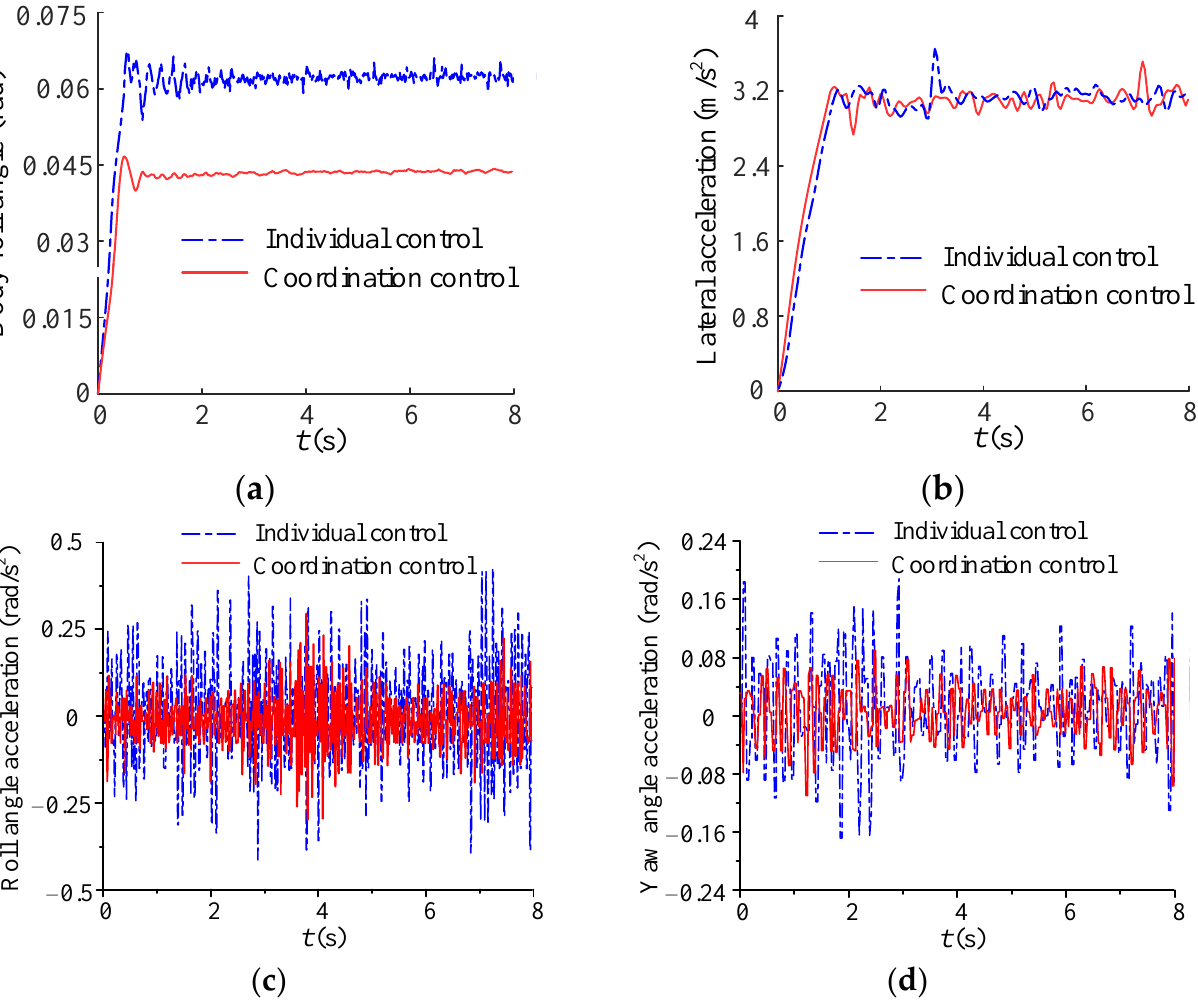
Figure 6. Response curves under step steering: ( a ) body roll angle; ( b ) lateral acceleration; ( c ) roll